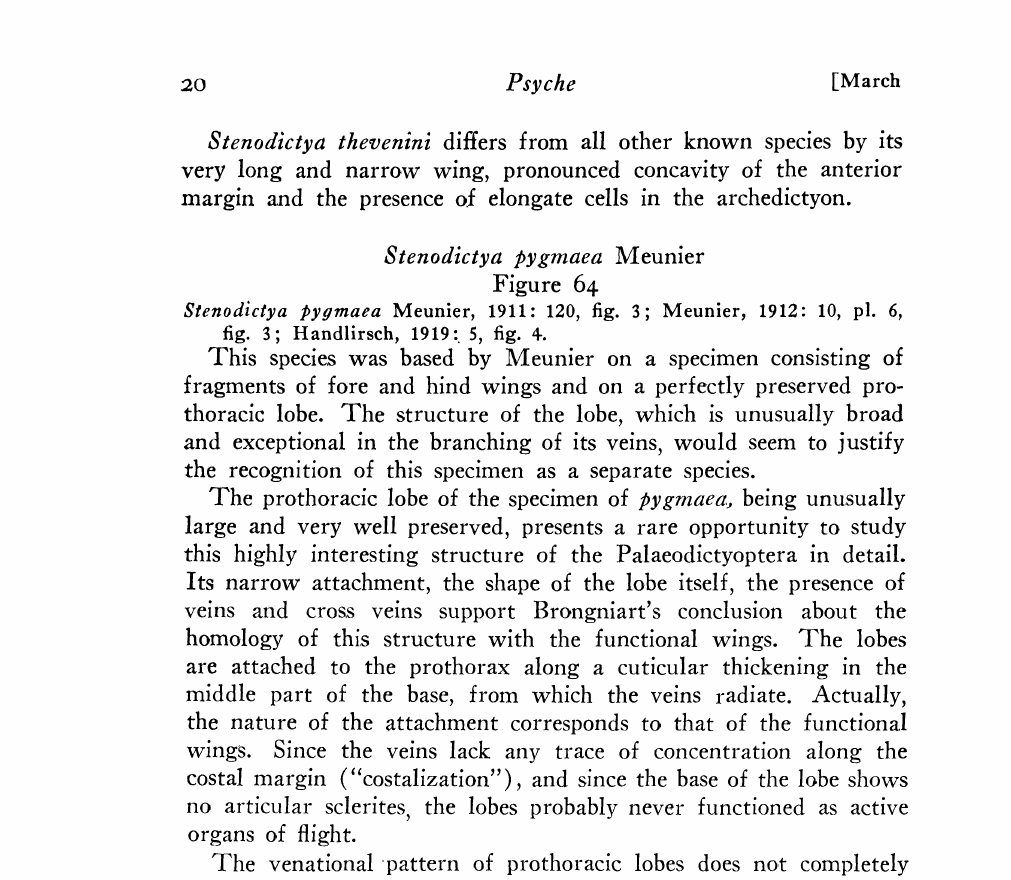
fig. 3; Handlirsch, 1919:. 5, fig. 4. This species was based by Meunier on a specimen consisting